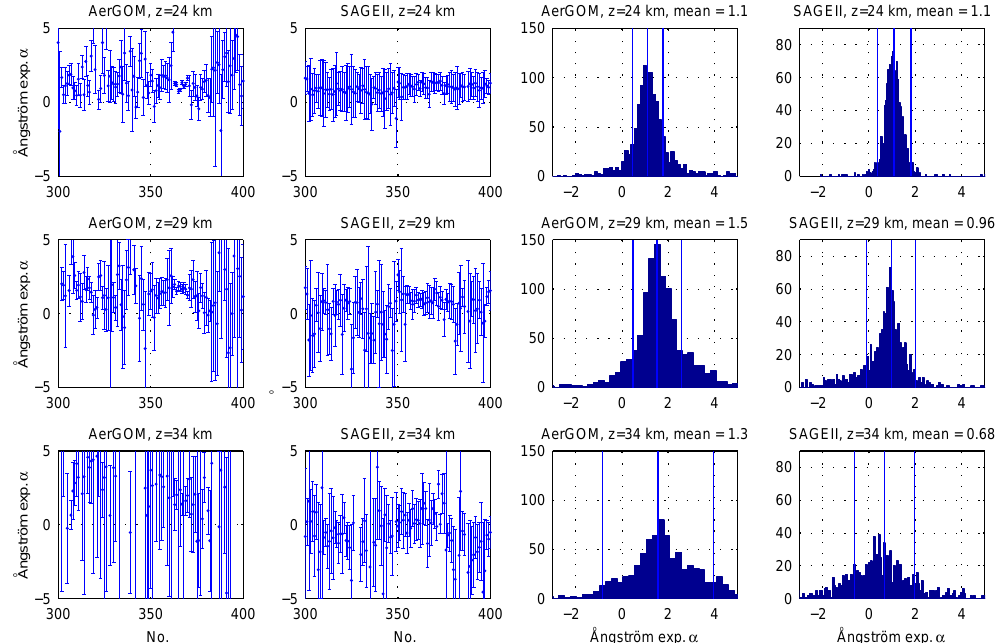
Figure 8. Ångström exponents (AEs) derived from GOMOS–AerGOM and SAGE II data. The same data as for Fig. 7 were used. First two columns: 100 examples of AE for AerGOM and SAGE II at three different altitudes, with error bars. Third and fourth column: AE histograms for the full set of 1152 GOMOS–SAGE II collocations at three different altitudes. Vertical lines represent the error-weighted mean of the distribution (central line), and the median experimental error bars of the AE. The AE weighted mean is also indicated in the subplot